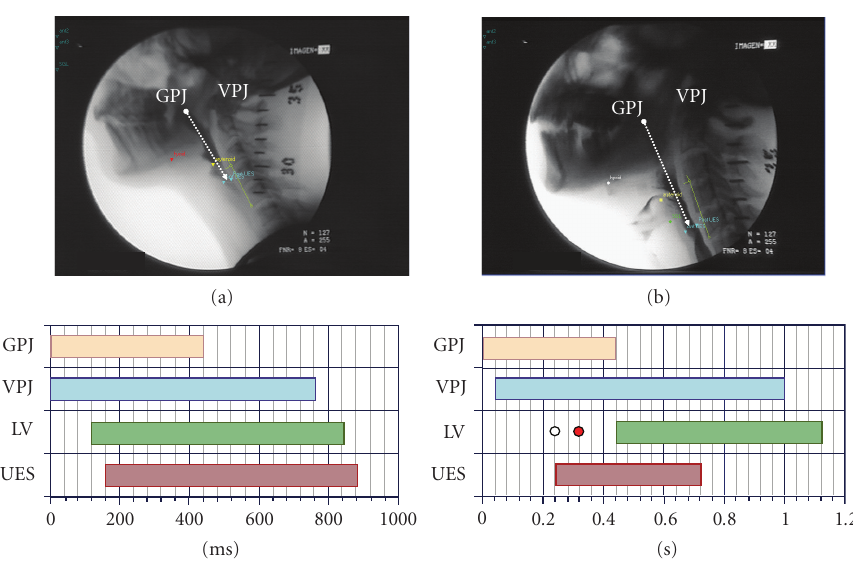
Figure 2: Videofluoroscopic pictures and oropharyngeal swallow response during the ingestion of a 5mL nectar bolus in: (a) a healthy individual; (b) an older patient with neurogenic dysphagia and aspiration associated with stroke. An increased total duration of the swallow response may be seen, as well as a delayed closure of the laryngeal vestibule and delayed aperture of the upper sphincter. The white dot indicates the time when contrast penetrates into the laryngeal vestibule, and the red dot indicates passage into the tracheobronchial tree (aspiration). GPJ = glossopalatal junction, VPJ = velopalatal junction, LV = laryngeal vestibule, UES = upper esophageal